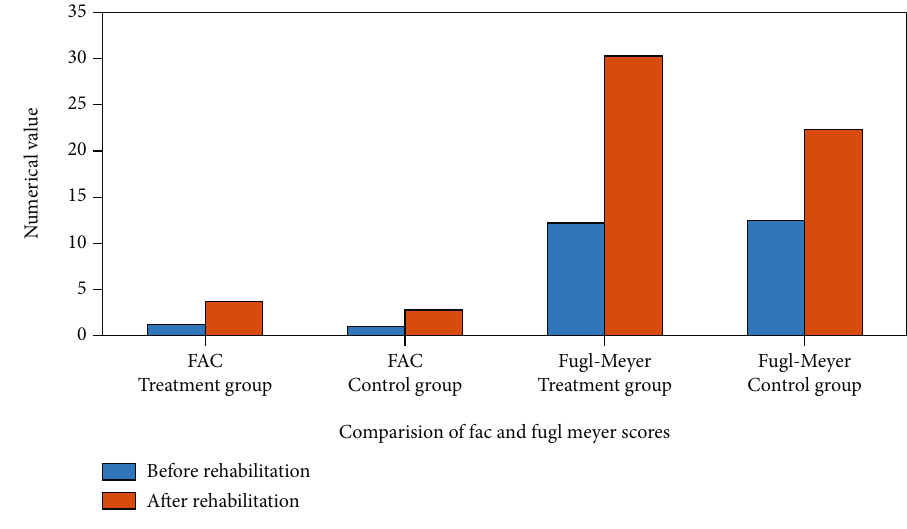
Figure 2: Comparison of FAC and Fugl-Meyer